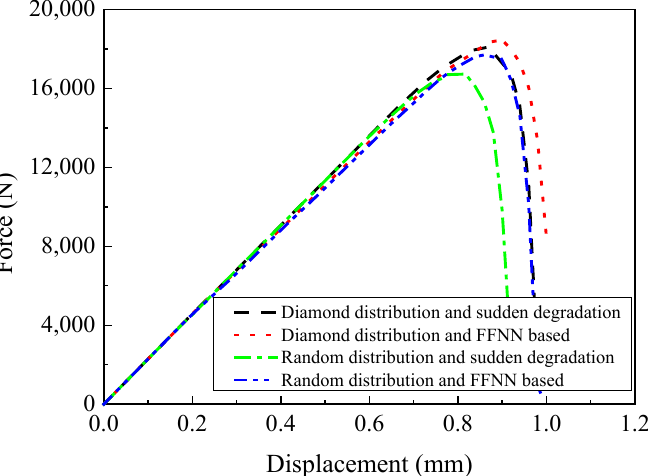
Figure 30. Predicted compressive responses considering different fiber arrangement patterns.